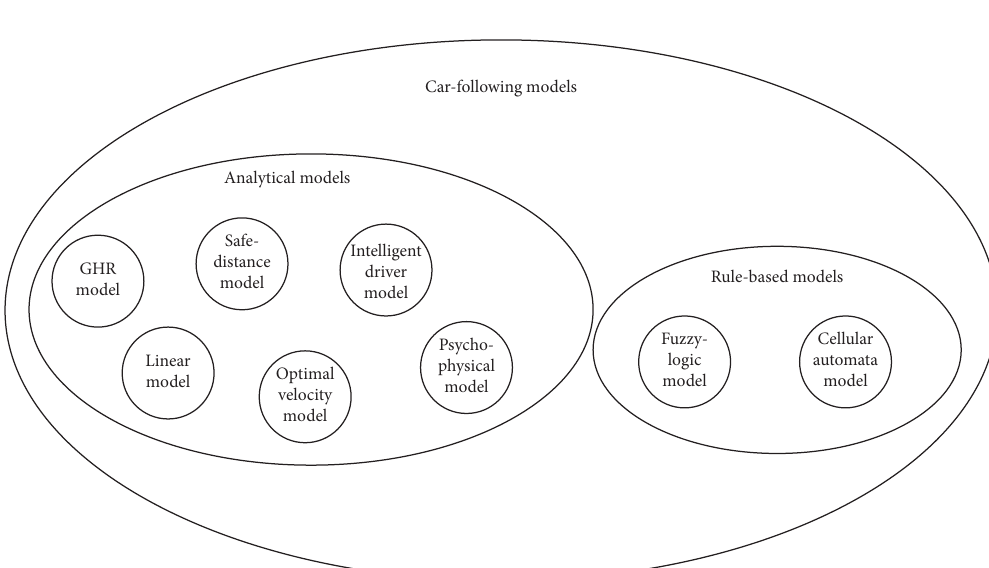
Figure 4: Various car-following models for homogeneous traffic